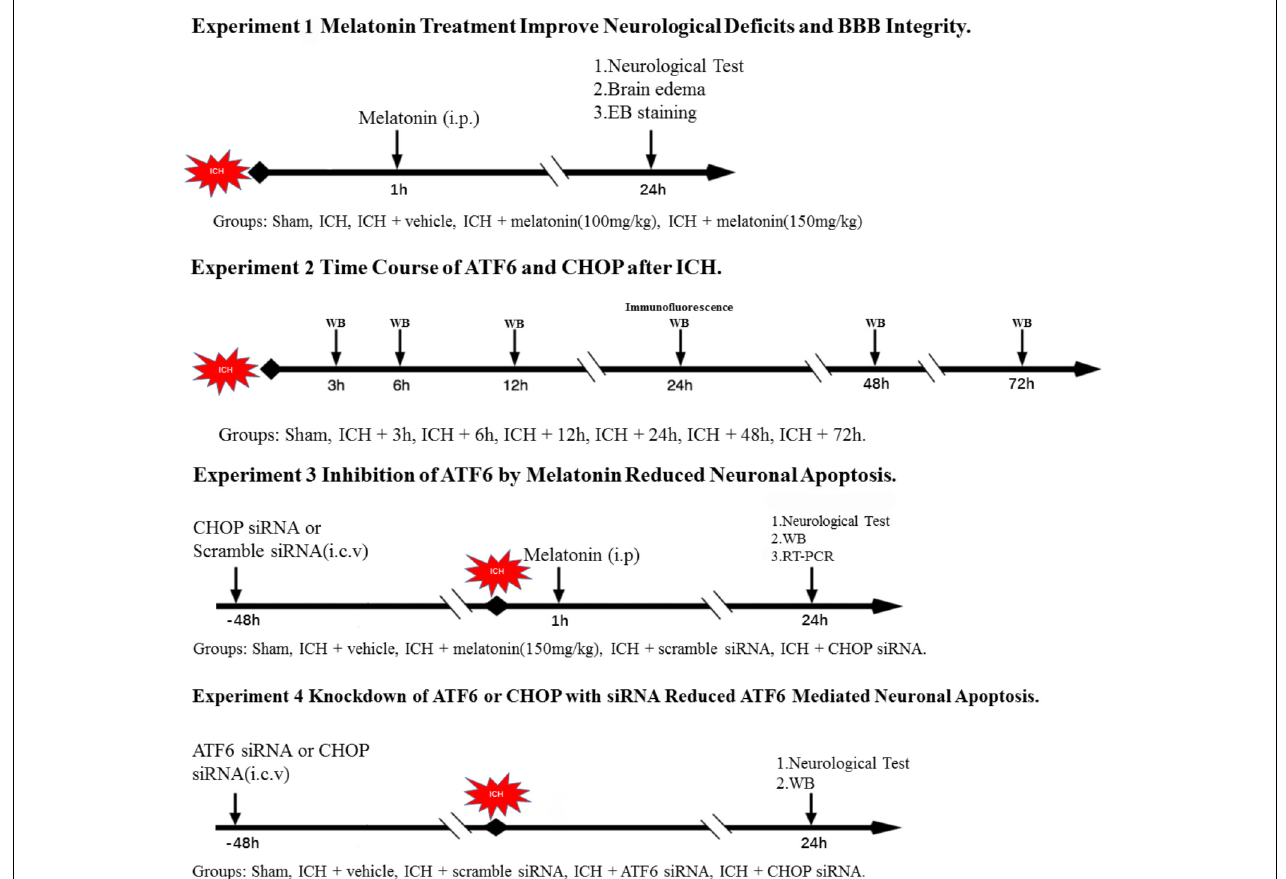
FIGURE 1 | Experimental design and animal